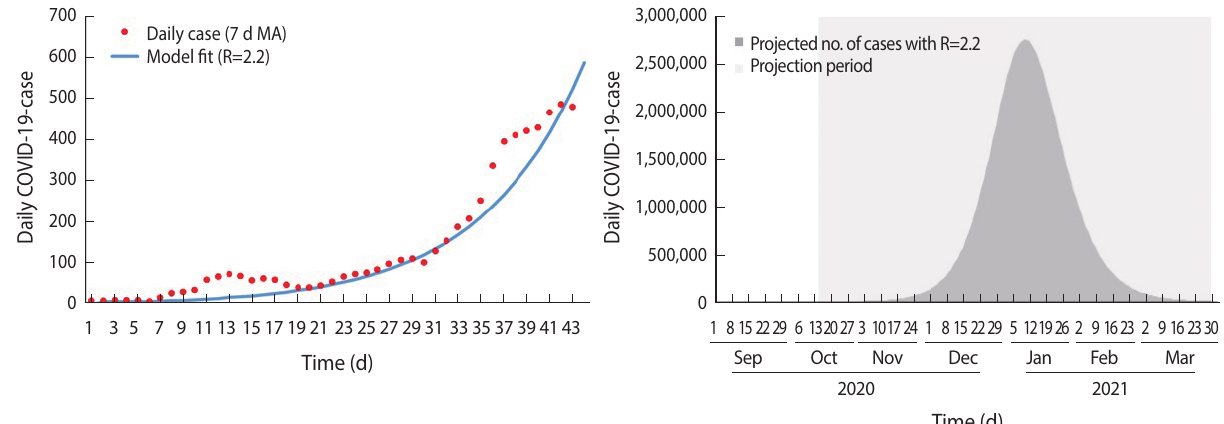
Figure 2. SEIR model fit and forecast for nationwide RMCO phase. SEIR, susceptible-ex posed-infected-recovered; RMCO, recovery move- ment control order; COVID-19, coronavirus disease 2019; MA, moving average.